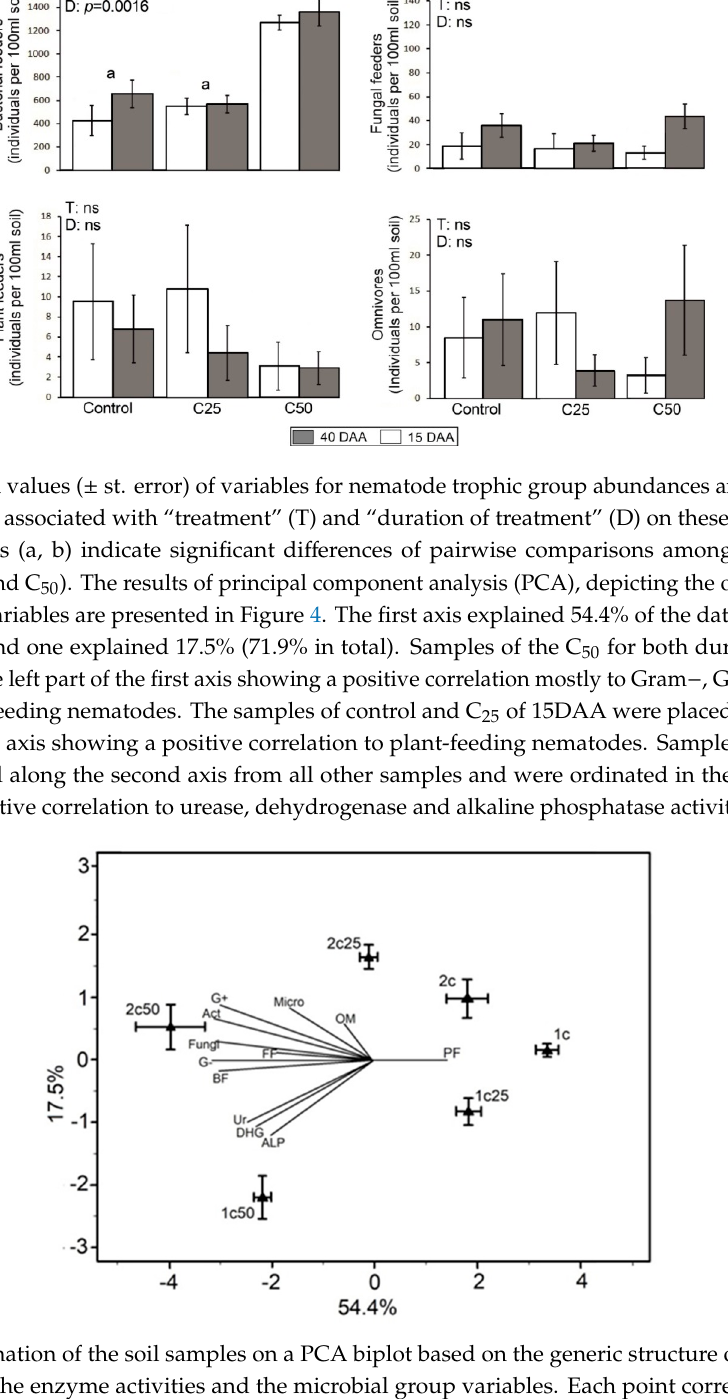
Figure 4. Ordination of the soil samples on a PCA biplot based on the generic structure of nematode communities, the enzyme activities and the microbial group variables. Each point corresponds to a sample collected at a specific time (1:15DAA, 2:40DAA), and from a specific treatment (Control, C 25 , C 50 ). Error bars indicate standard errors.